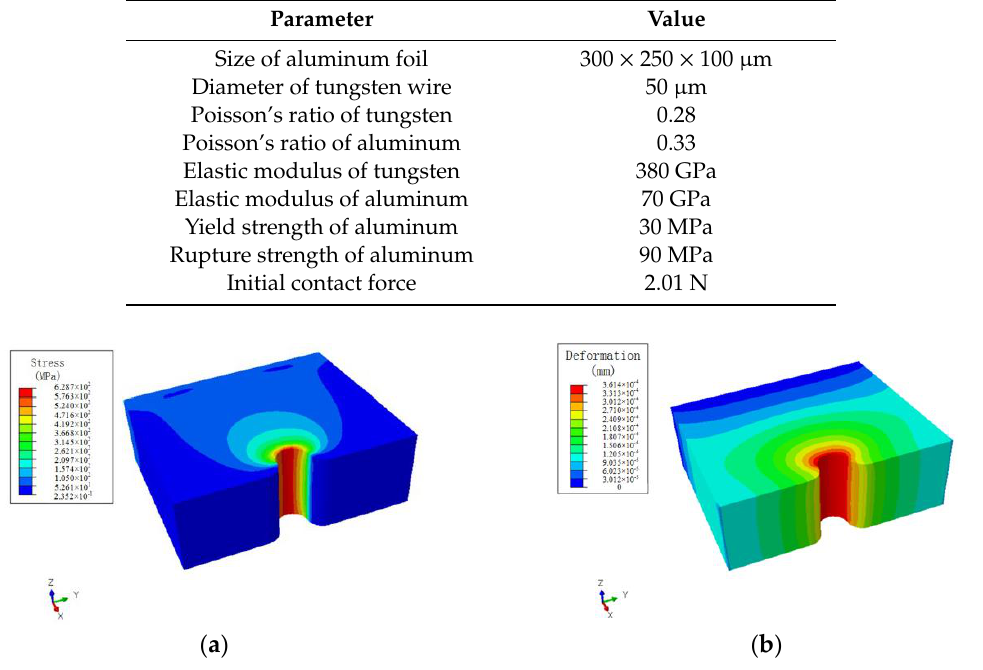
Table 1. Simulation parameters.